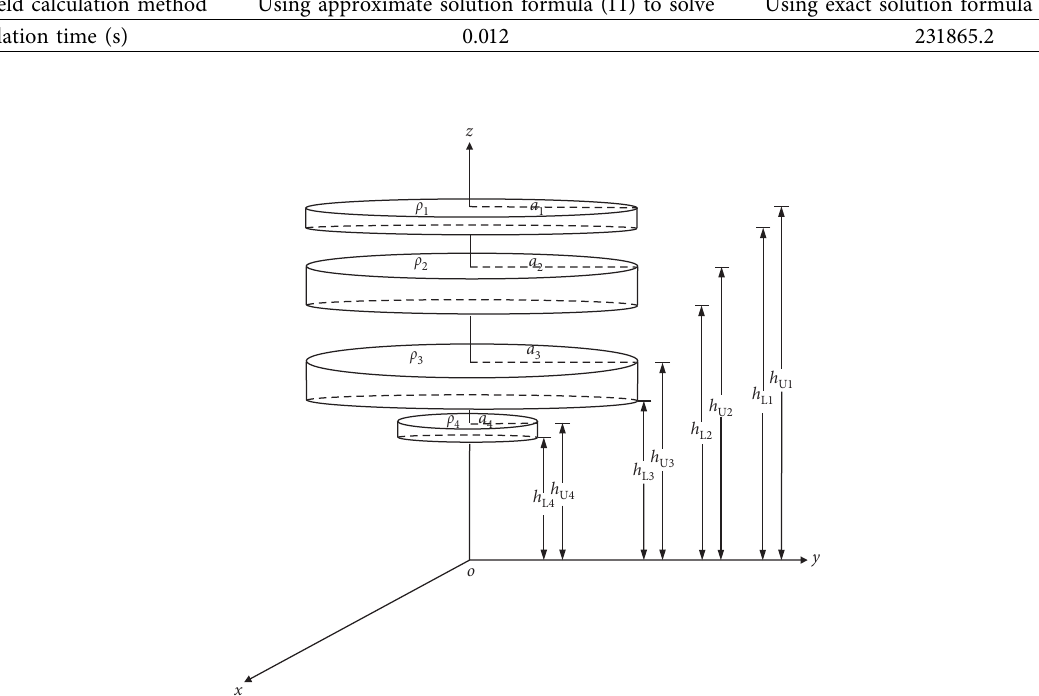
Figure 8: Thundercloud cylindrical four-layer charge stack